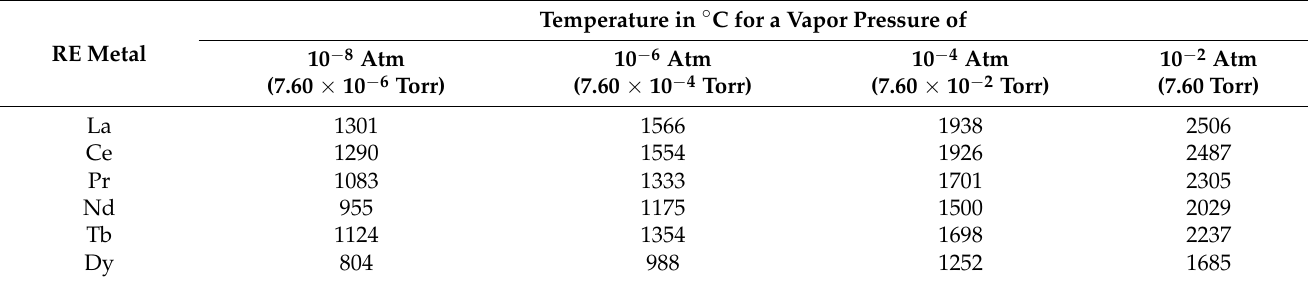
Table 1. Temperatures of several RE metals in different vapor pressures. The data are extracted from